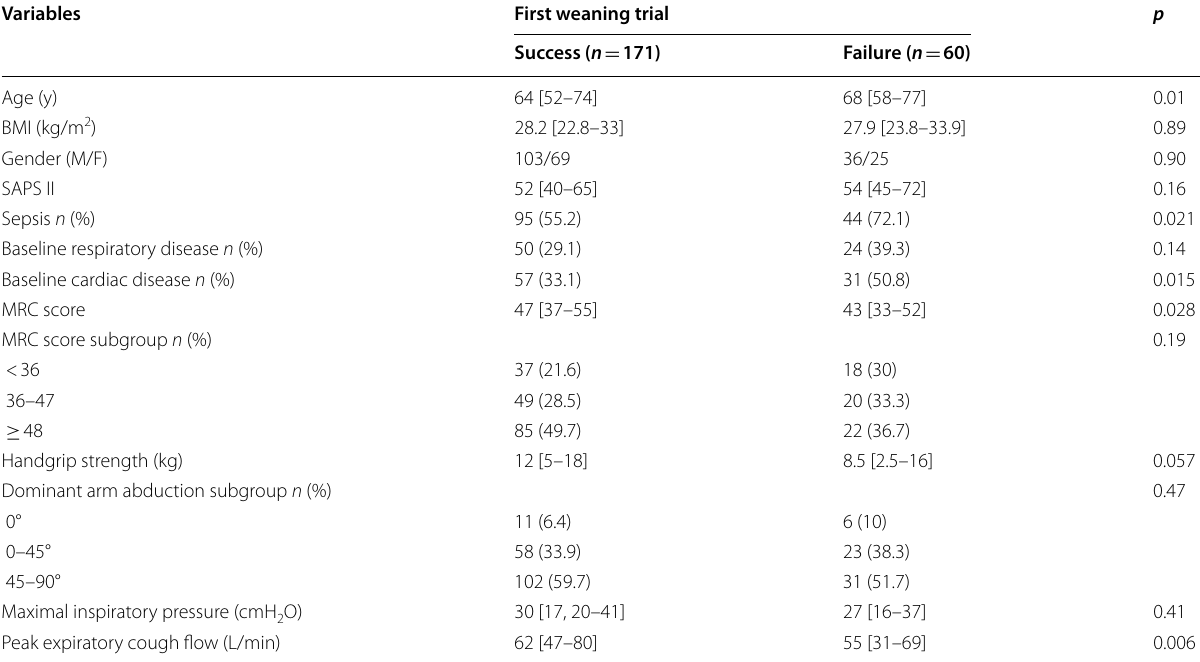
BMI body mass index, SAPS Simplified Acute Physiology Score, MRC Medical Research Council